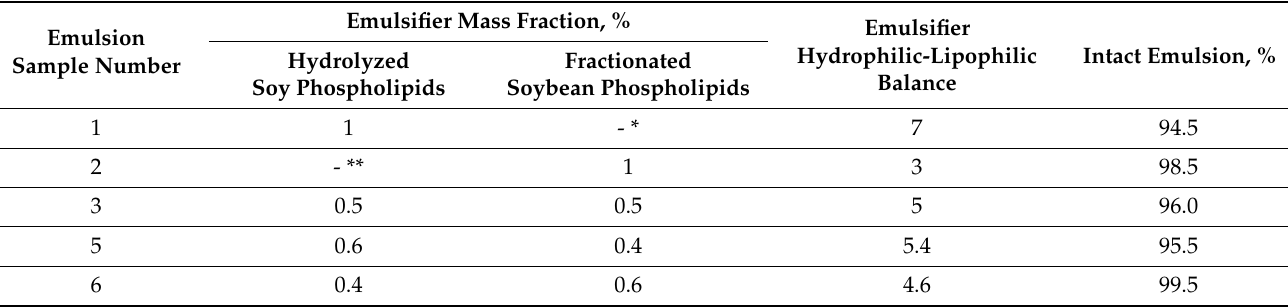
Table 7. Colloidal stability of the emulsions.